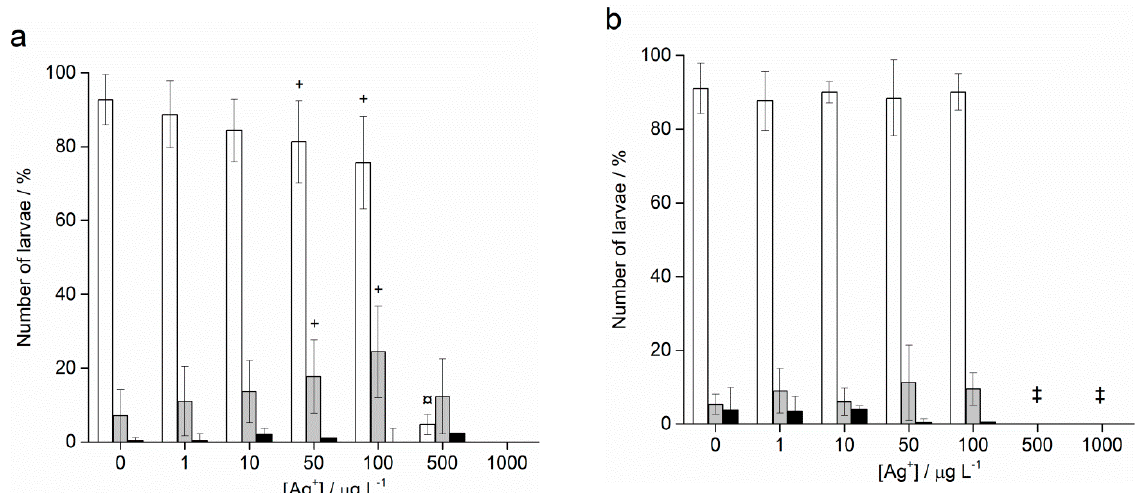
Figure 7. Offspring quality of ( a ) A. lixula and ( b ) P. lividus whose sperm was pre-treated for 1 h with Ag + ions before fertilisation. White columns show normally developed larvae and gray columns developmentally delayed and defective larvae, while black columns indicate embryos with arrested development ( ± SD). Significance levels: + p < 0.05 and ¤ p < 0.01. (‡ only unfertilised eggs observed).